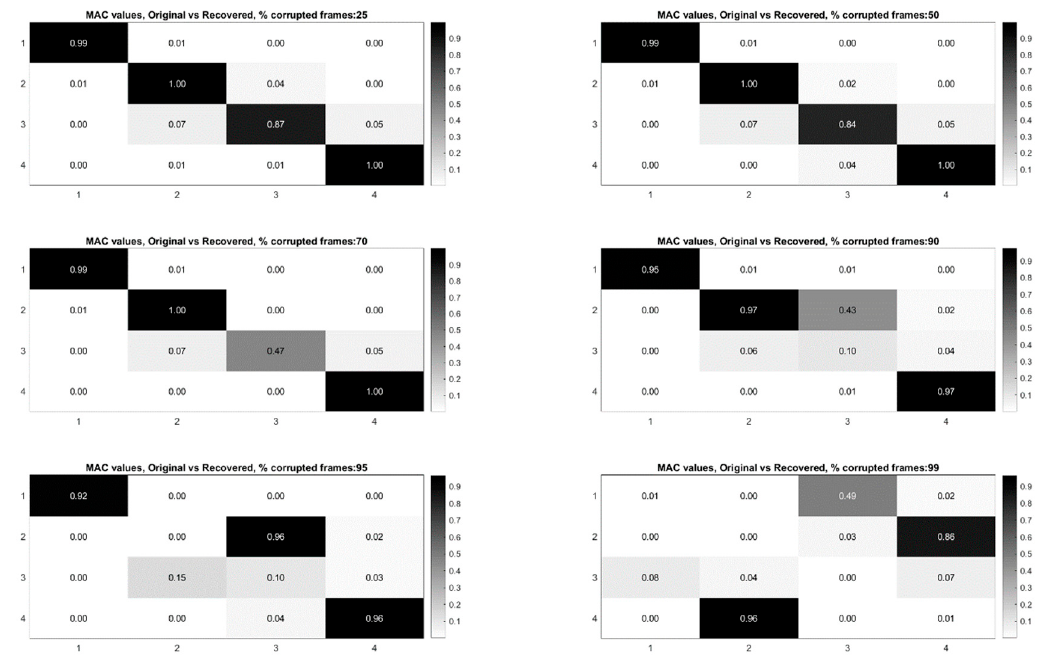
Figure 17. Modal assurance criterion values for the mode shapes recovered using L1 minimization on the PCA components. Each MAC matrix corresponds to a different percentage of corrupt/removed frames.